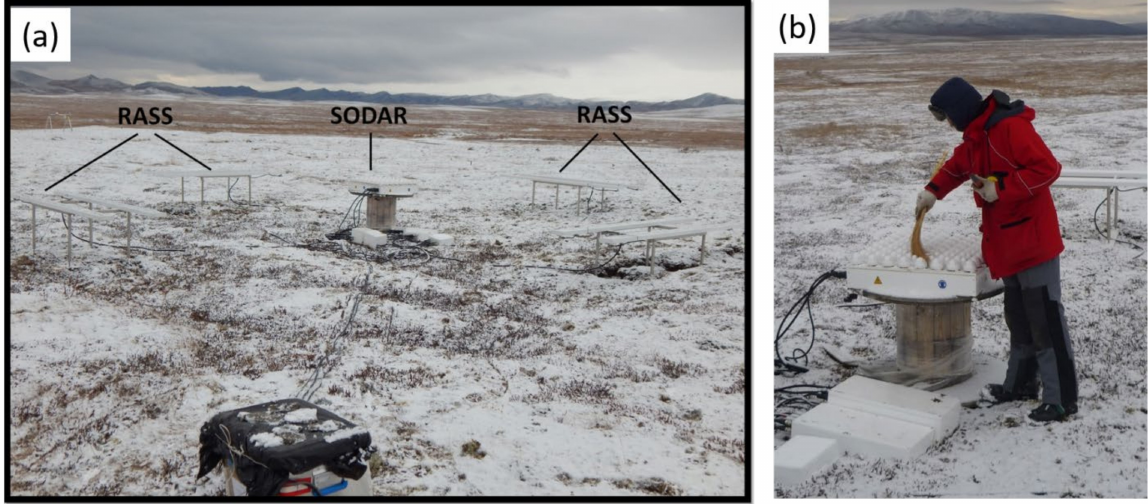
Figure 5. ( a ) Setup of the SODAR/RASS (view in south-west direction, photo: P. Schwarz). ( b ) Maintenance of the SODAR after snowfall (photo: C.